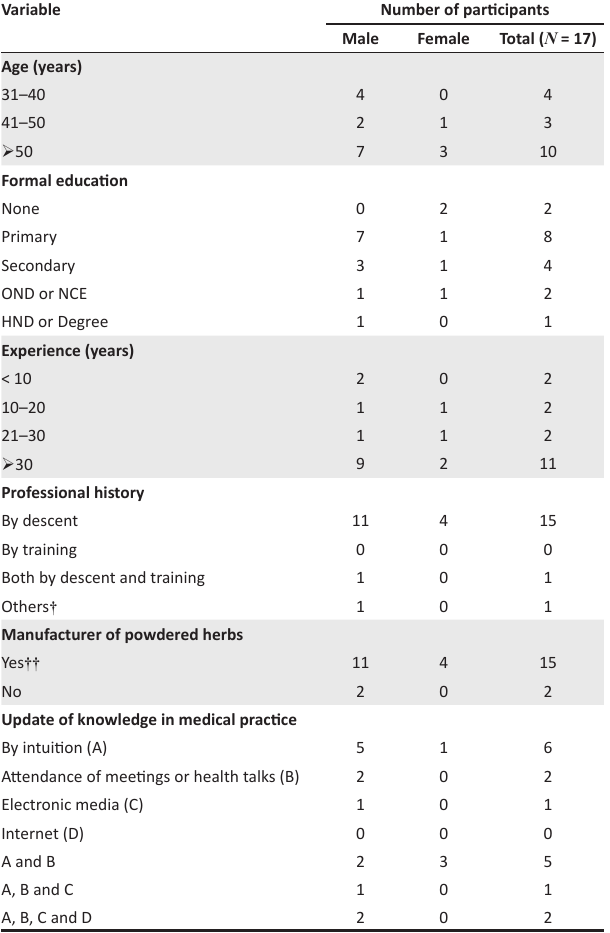
TABLE 1: Information about the traditional herbal healers who participated in the study. Variable